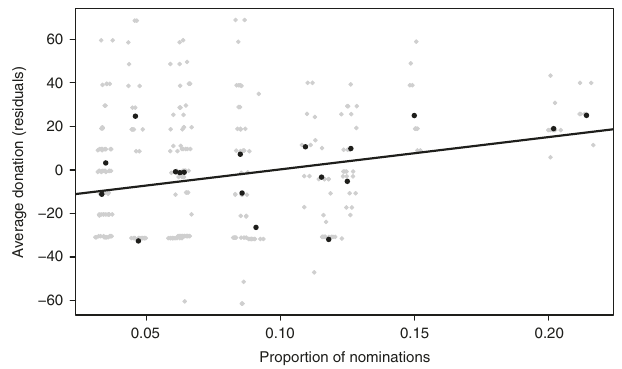
Fig. 1 Association between cooperation and storytellers in camp. Results of the multi-level linear regression model, indicating an association between the average proportion of nominations for being a skilled storyteller in each camp and the amount given to others in the resource allocation game ( b = − 215.6, 95% CI: [ − 47.8; − 383.4], p = 0.012). To facilitate interpretation, a higher value on the y -axis indicates a greater proportion of resources given to others (i.e. more cooperation). Residual values control for average camp relatedness, camp size and municipality ( n = 290, camps = 18). For coef fi cients of the full model see Supplementary Table 3. Black points: camp averages; grey points: individual data